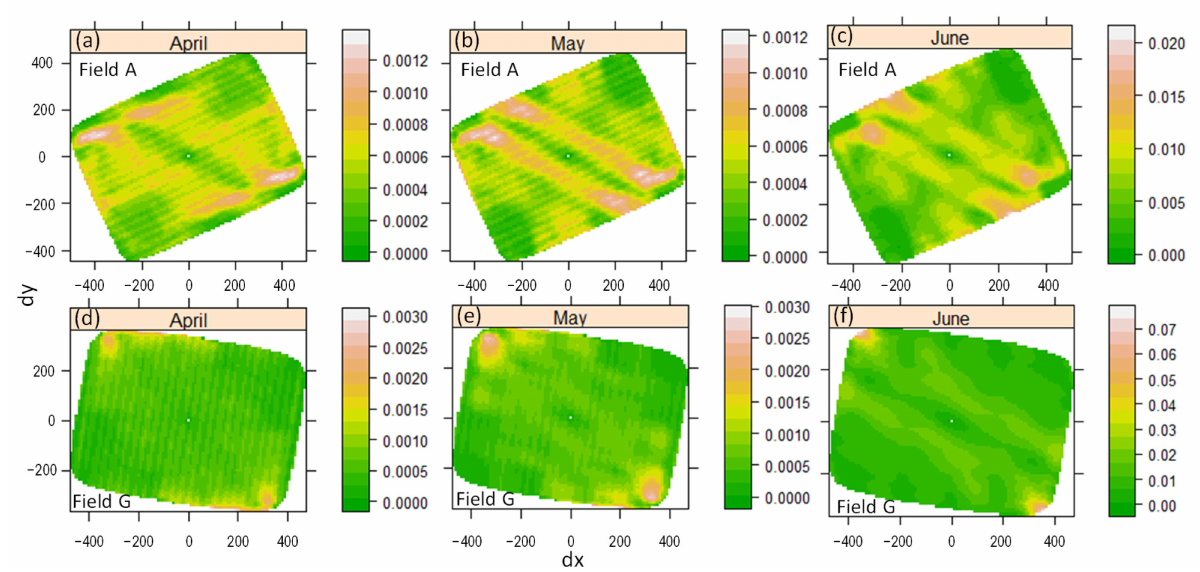
Figure 8. Semivariogram maps of NDVI maps calculated based on raw Sentinel-2 data at different growth stages from field A and wheat crop ( a – c ), field G and barley crop ( d – f ) in: ( a ) April 2019, ( b ) May 2019, and ( c ) June 2019 of field A, ( d ) April 2019, ( e ) May 2019, and ( f ) June 2019 of field